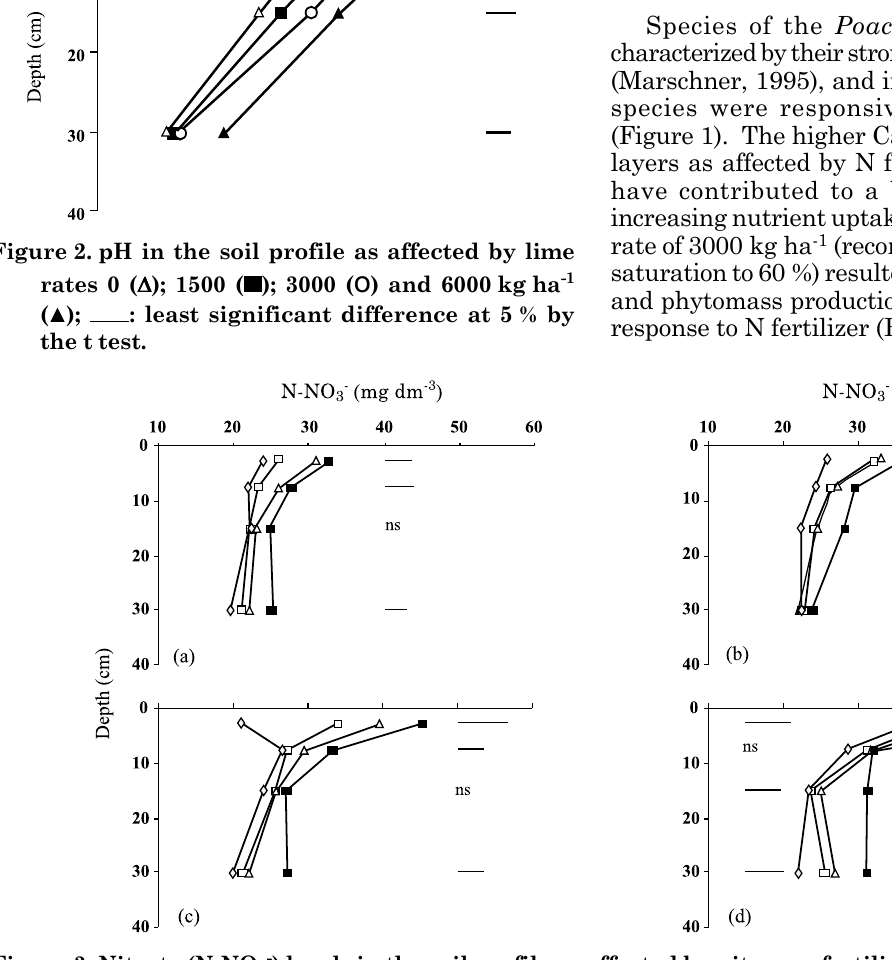
Figure 3. Nitrate (N-NO 3- ) levels in the soil profile as affected by nitrogen fertilization ( ): 0; ( ): 50; ( ΔΔ ΔΔ Δ ):